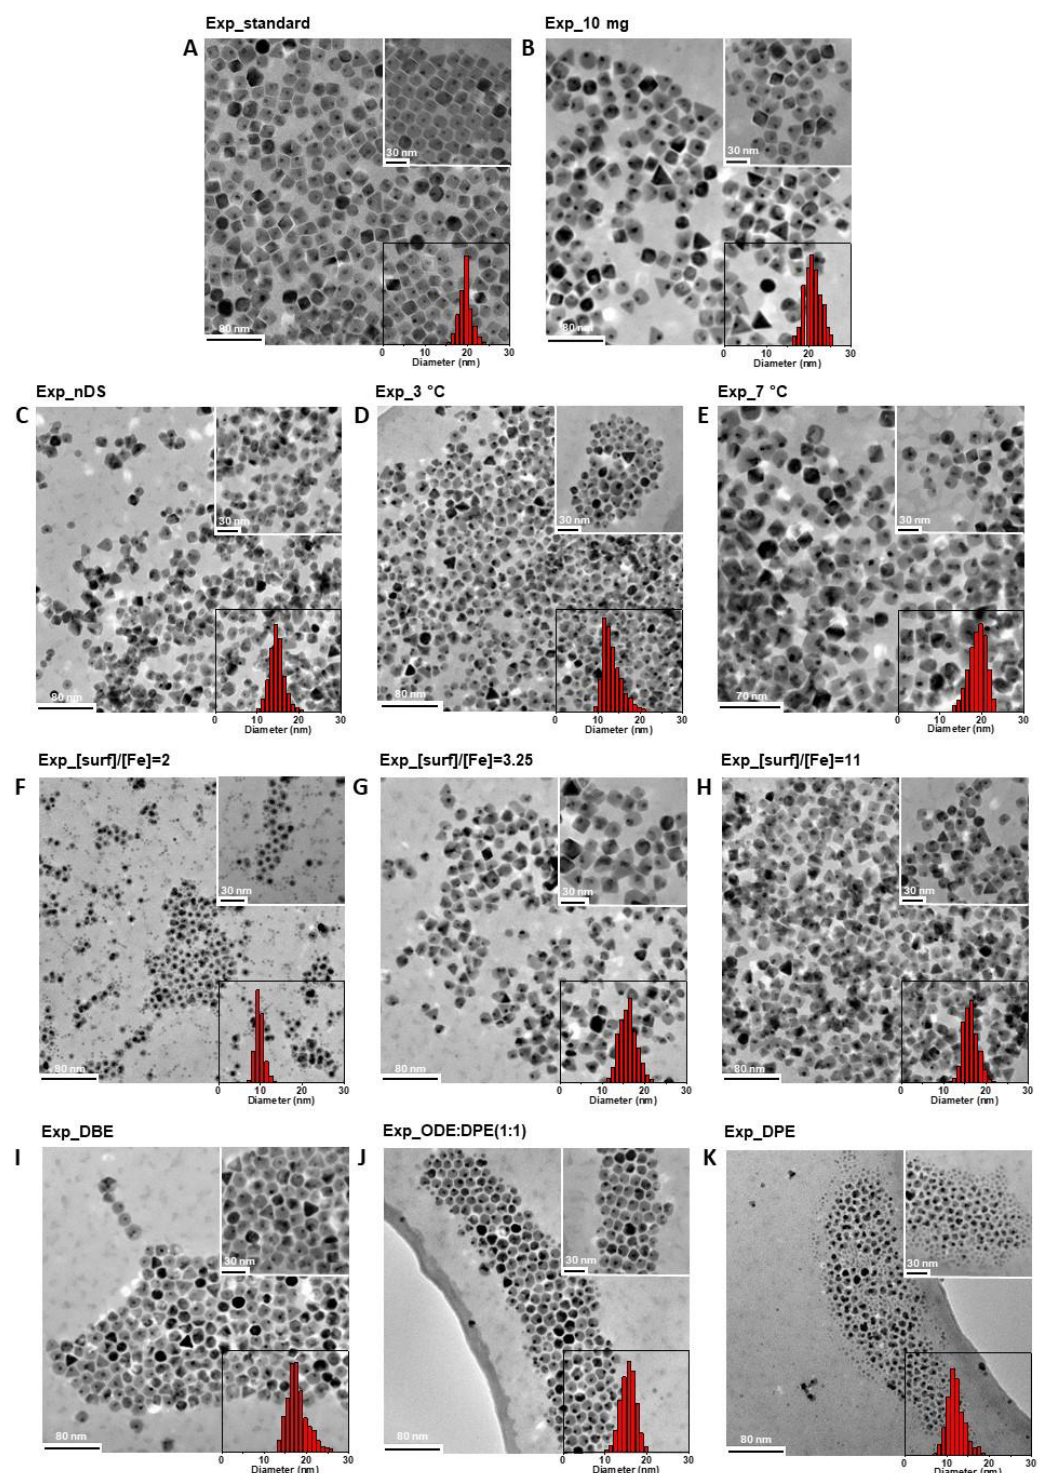
Figure 2. TEM images of Pd/Fe-oxide NPs obtained through seed-mediated synthesis, including expansions (insets top right ) and the corresponding size-distributions (insets bottom right ). Characteristics of NPs batches are summarized in Table 1.